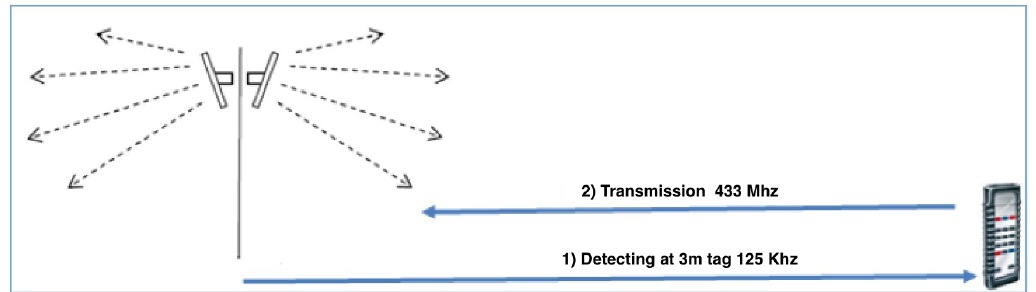
Figure 11. Communication between the transponder and the